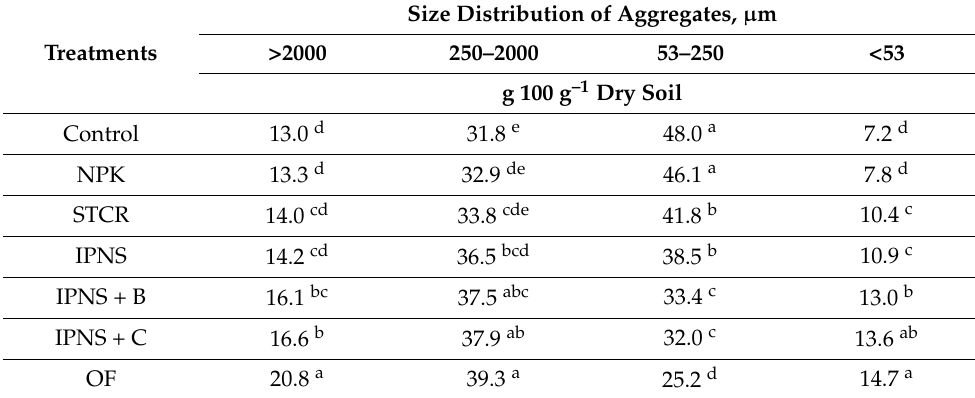
Table 2. Soil aggregation distribution as affected by long-term nutrient supply options of rice–wheat system in the 0–15 cm soil layer. Means of different treatments followed by the different lower-case letter are significantly different at p < 0.05 level of significance according to DMRT.